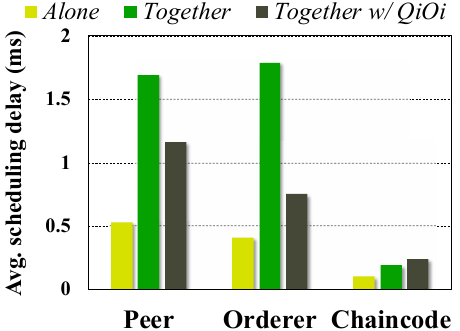
Figure 7. Comparison of scheduling delay for Fabric components. Table 4. Sysbench throughput depending on the value of k . The Value of k